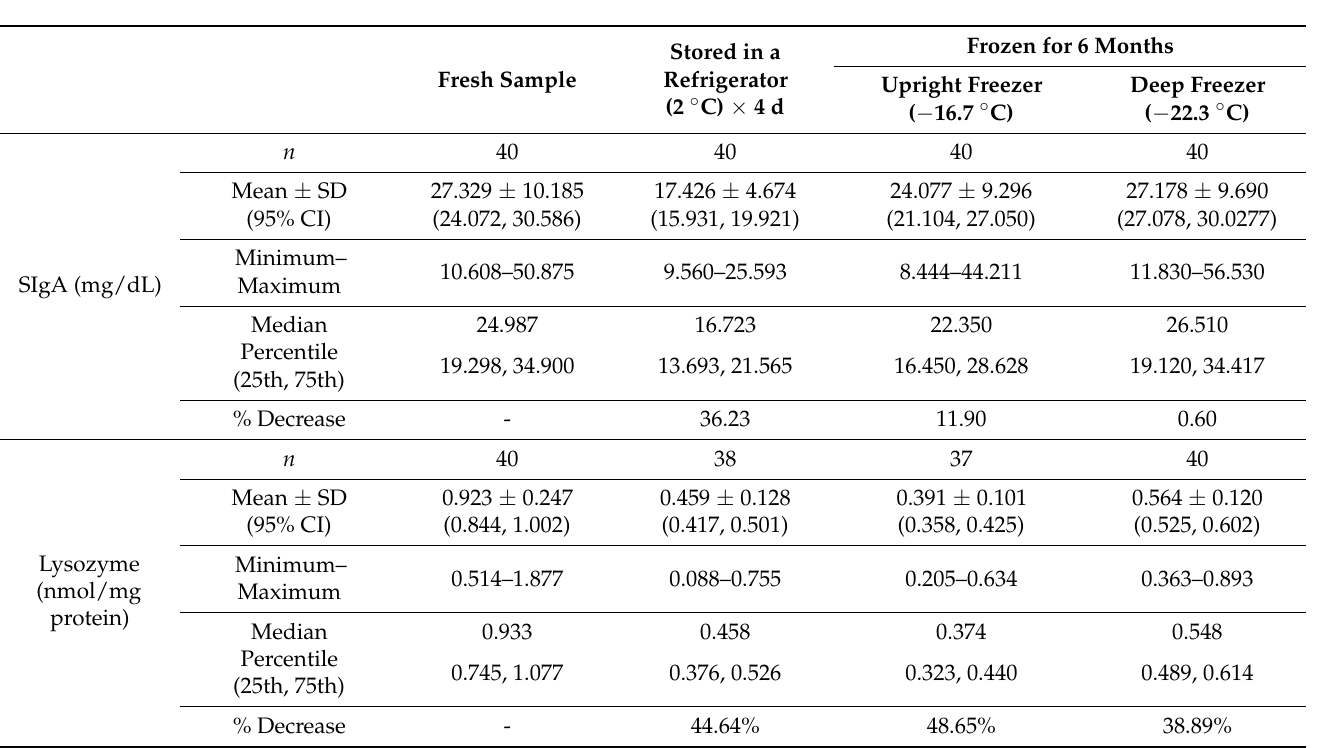
Table 3. SIgA and lysozyme activity levels detected in fresh HM and HM samples frozen at − 18 and − 20 ◦